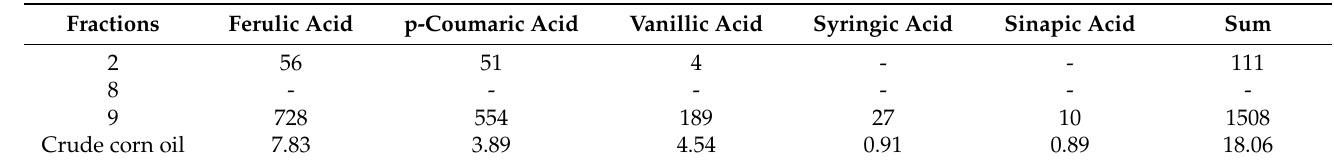
Table 4. Phenolic acids detected in fraction 2 and fractions 8, 9 after SPE fractionation strategy. Values are expressed as µ g/g.